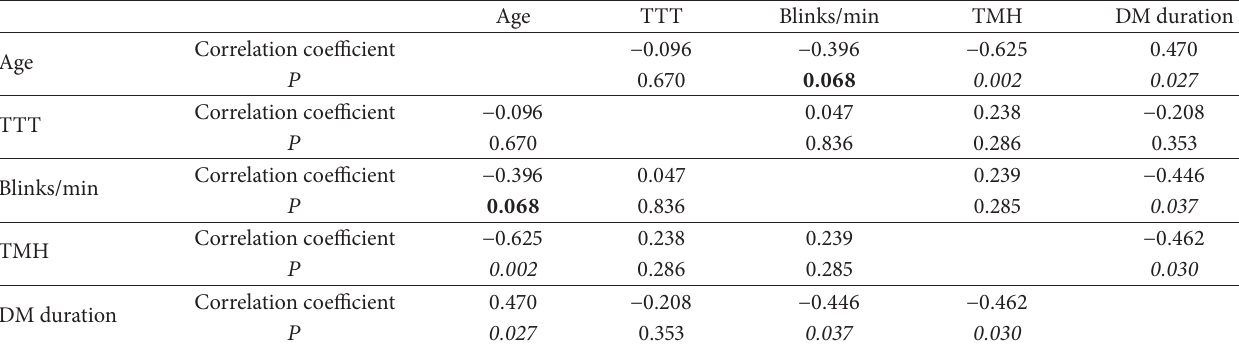
Table 2: The cross relations in Group A.